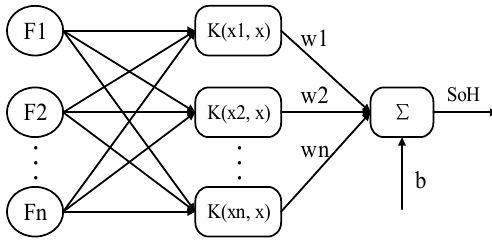
Figure 2. The schematic diagram of LS-SVM model for SOH estimation.